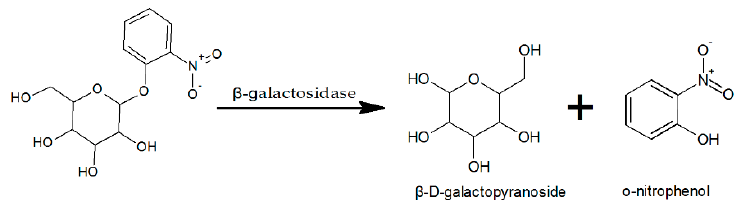
Figure 1. Catalytic reaction of β -galactosidase.